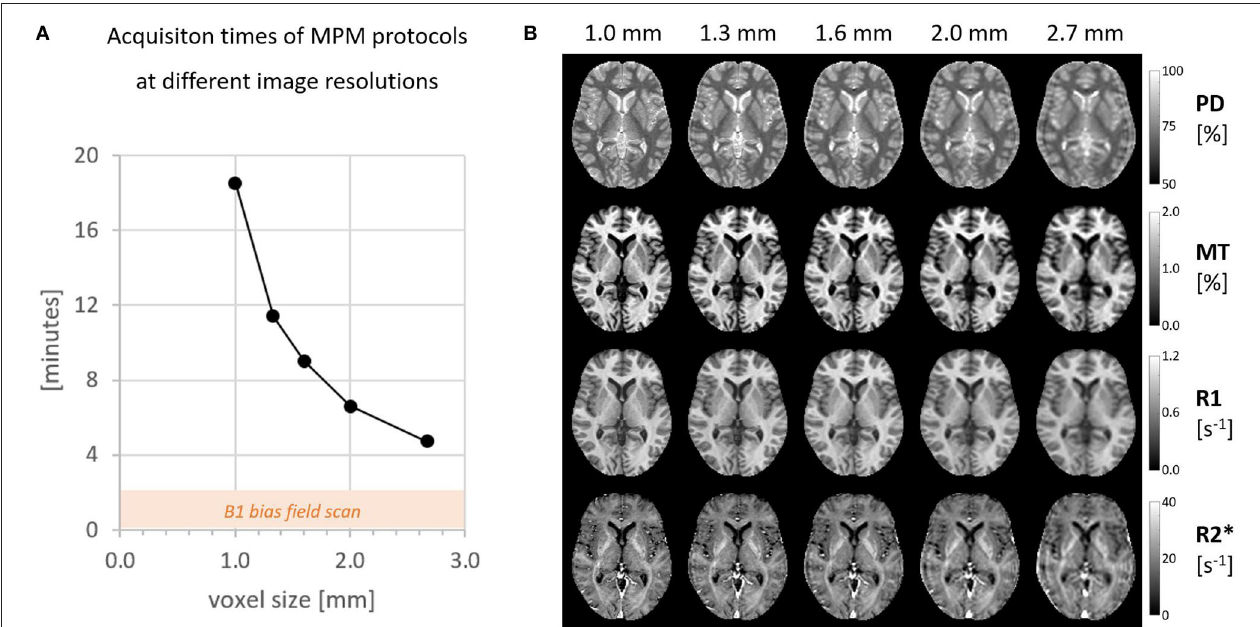
FIGURE 2 | (A) Scan-rescan variability within the white matter at different isotropic resolutions on the example of proton density contrast. Increasing the voxel size decreases scan-rescan fluctuations until a point (red dashed line) where we assume physiological noise starts to dominate. A decrease in voxel size below 1.6mm (red arrow) comes at the cost of longitudinal stability and longer acquisition times (compare Figure 1A ), which are incompatible with the needs of clinical routine. Correcting for Gibb’s ringing increases stability (blue vs. red circles), especially at higher image resolution. (B) One exemplary slice (1.6mm resolution) illustrating the advantages of Gibb’s ringing correction on image quality and stability, especially in areas close to sharp tissue boundaries (red arrow).